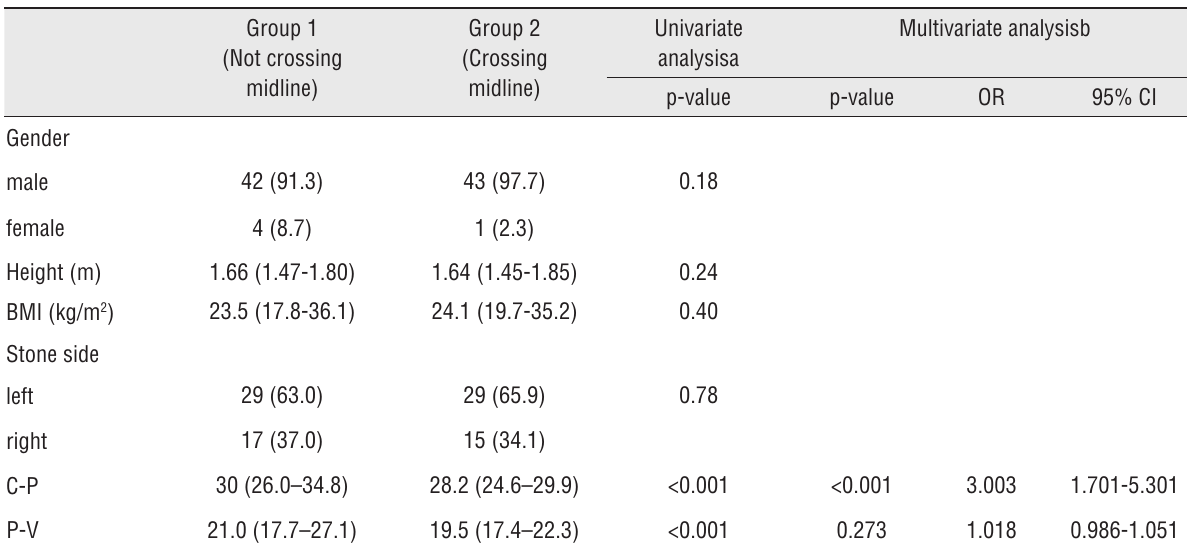
Table 2B - Multivariate analysis of patients with 26 cm ureteral